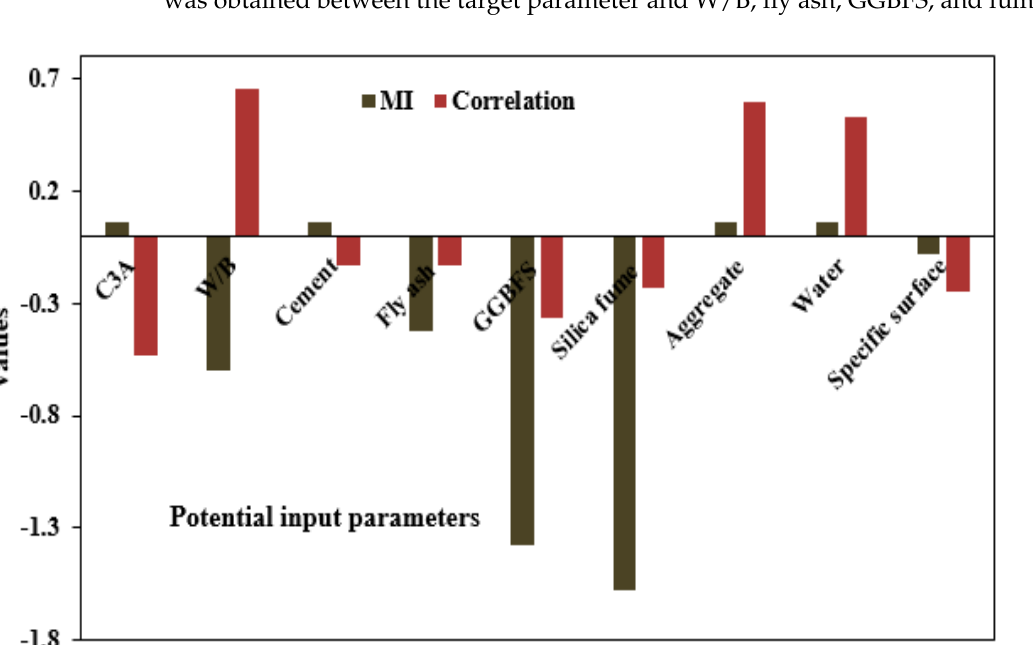
Figure 2. Determination of the relevant input variables using the MI